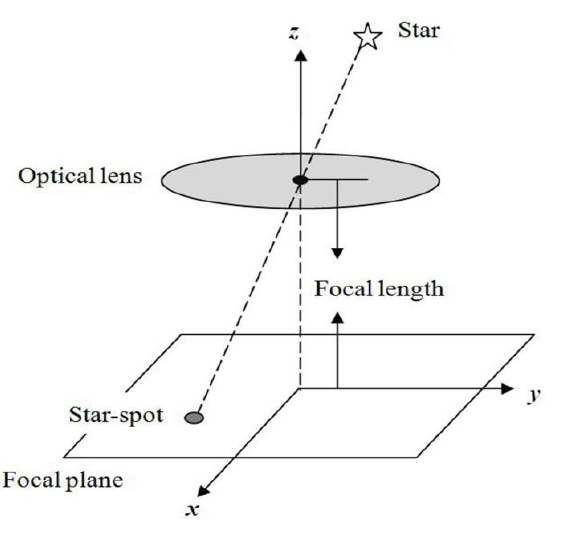
Figure 1. Static star-spot imaging